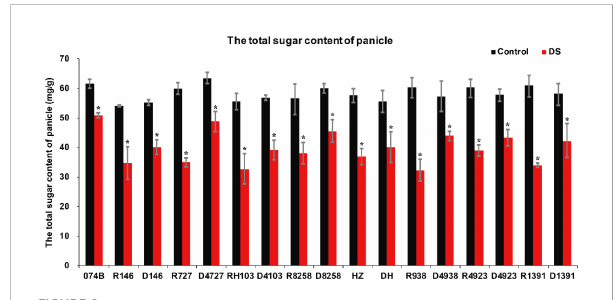
FIGURE 9 Total sugar content of restorer lines and hybrid progeny after drought stress treatment. DS represents drought stress treatment. Error bars denote standard deviations ( n = 3); “ * ” stands for signi fi cance between drought stress and control condition in the same cultivar (p ≤